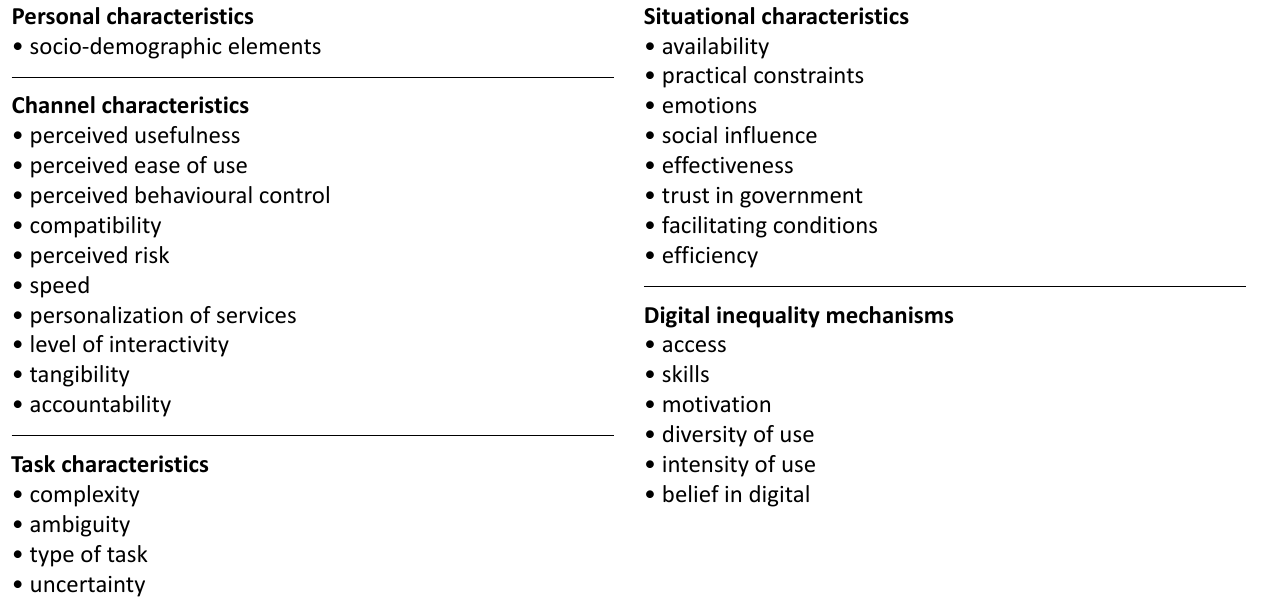
Table 1. Conceptual framework of channel